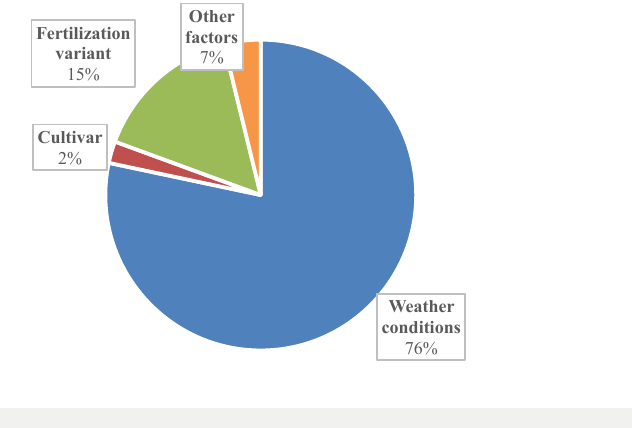
Figure 7 Factors affecting the formation of the winter wheat yield.